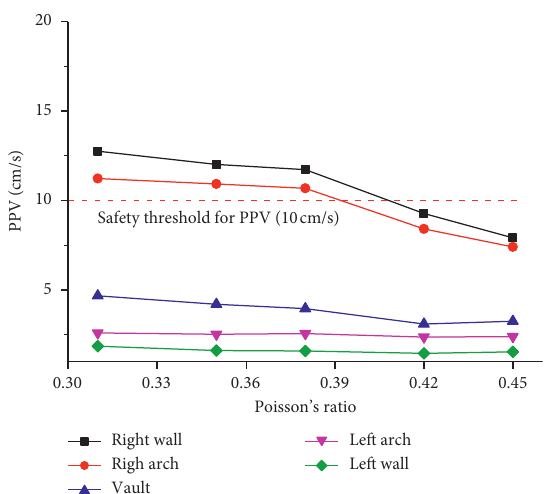
Figure 13: Changes of maximum PPV with explosive speed.